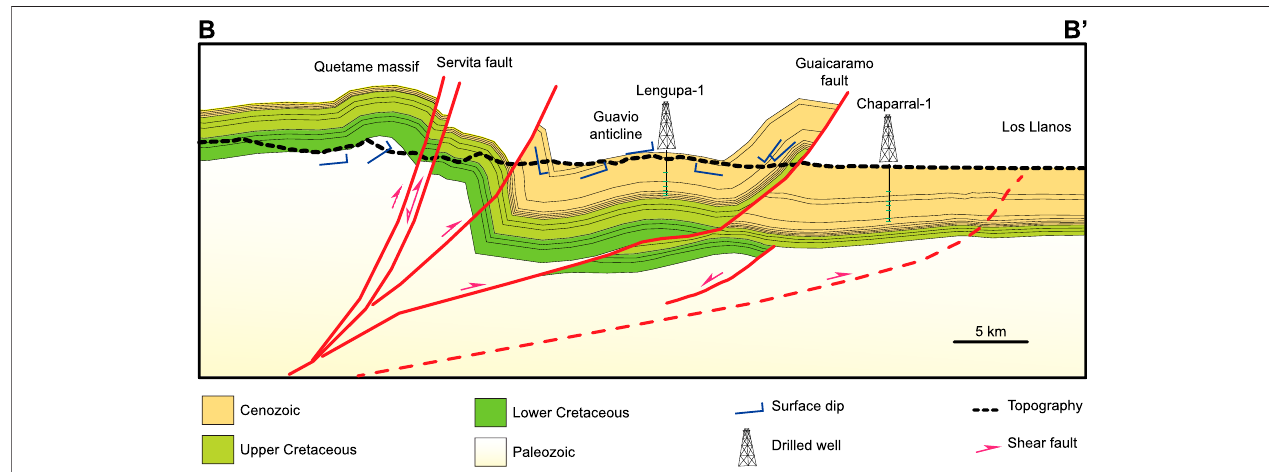
FIGURE 4 | Structural section constructed along the Medina Basin area using the kink method (see location in Figure 1 ). The principal elements for the section construction are: 2D seismic pro fi les, geological contacts, surface dips, well markers and dips, and the topographic pro fi